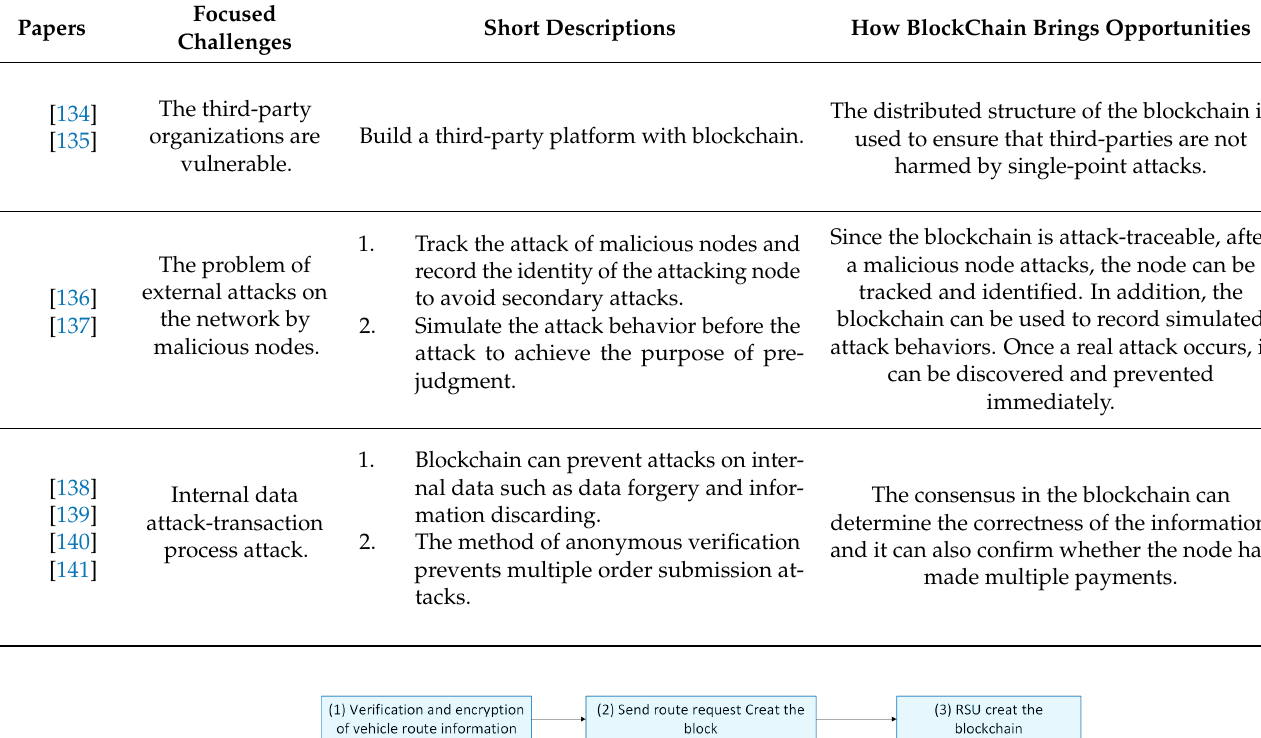
Table 7. protecetion of attack Management Related Papers.